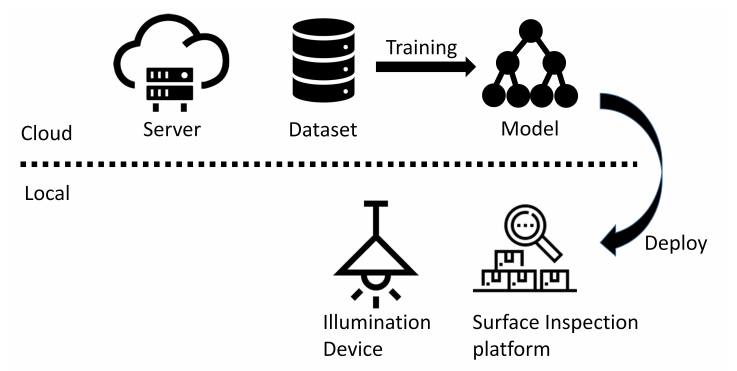
Figure 7. The proposed online inspection